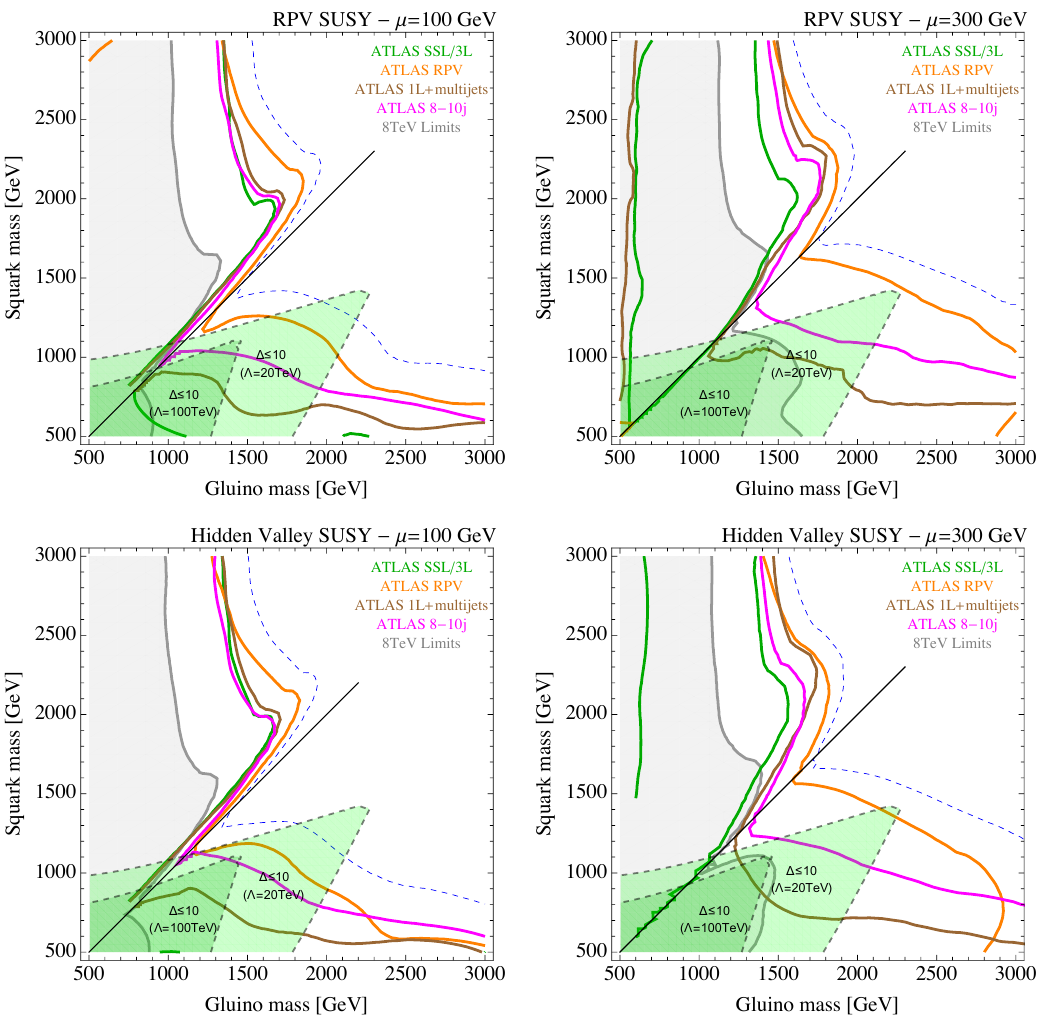
Figure 4 . Limits on the RPV (top) and HV/Stealth SUSY (bottom) models with (cid:22) = 100 GeV (left) and 300 GeV (right) as a function of the gluino and the degenerate squarks masses. All other conventions are as in (cid:12)gure